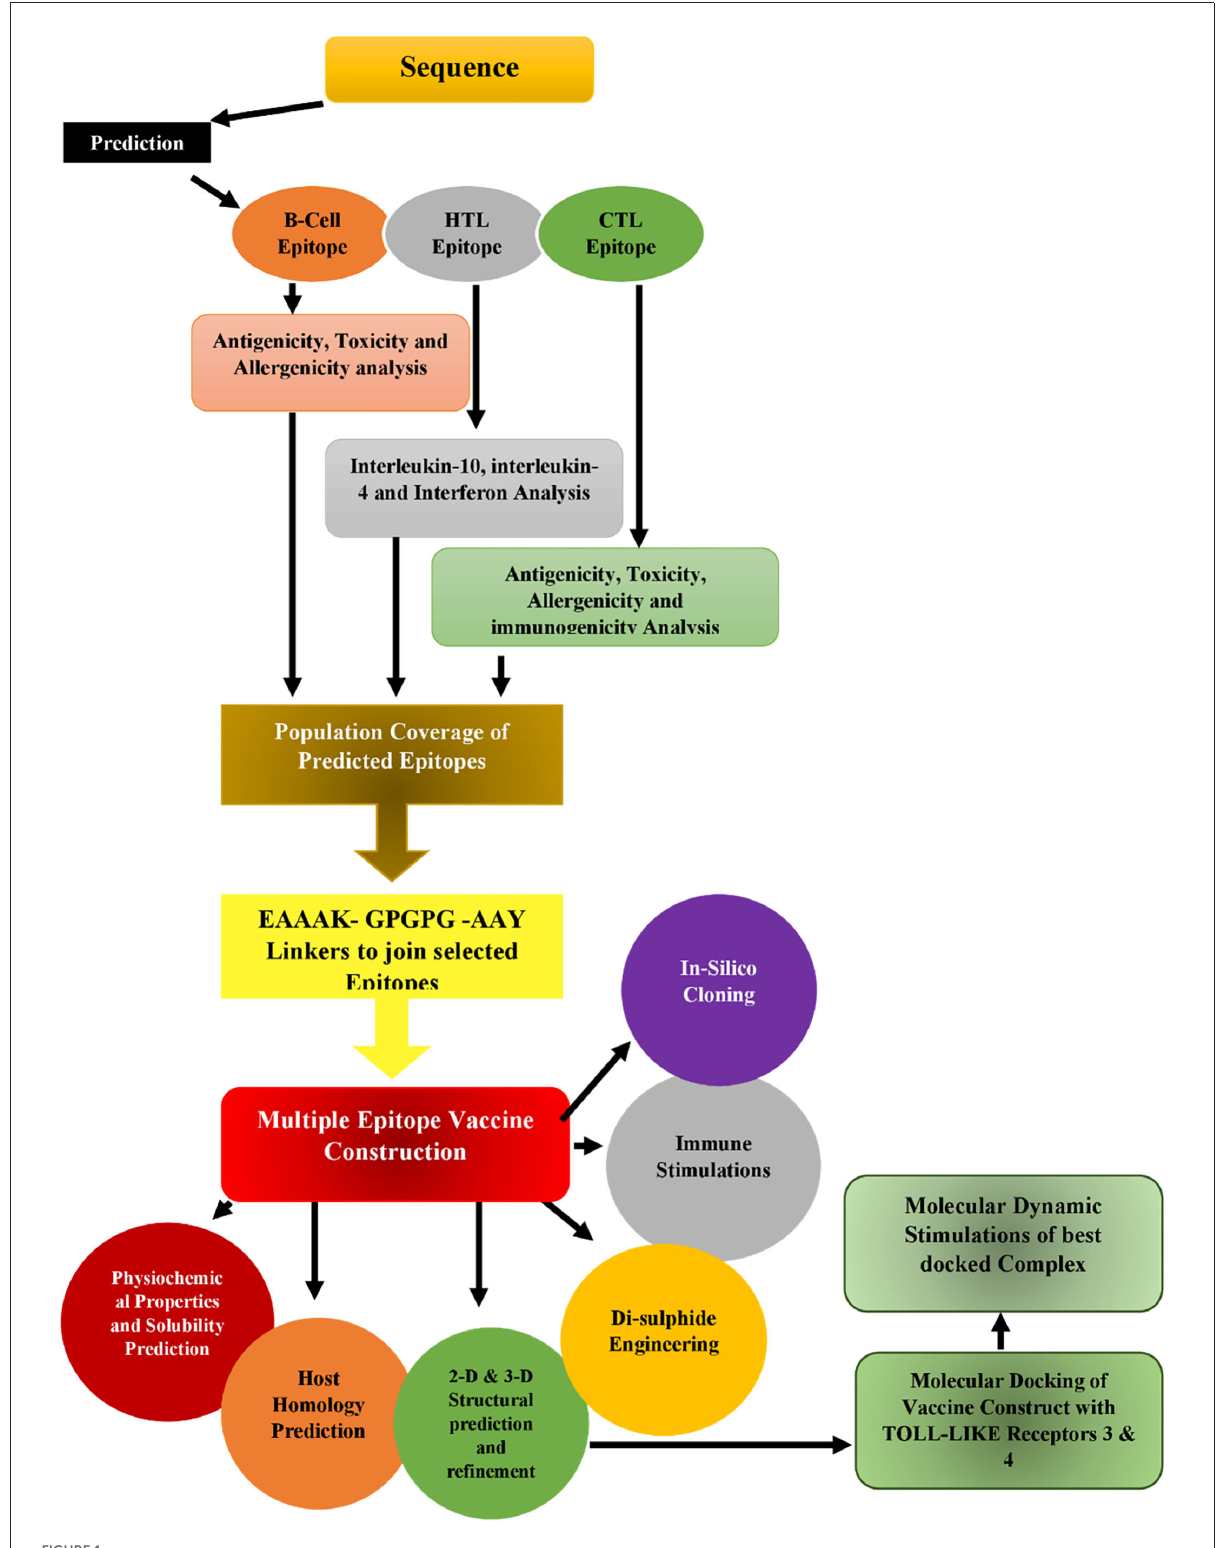
FIGURE1 Flow diagram of an in silico vaccine